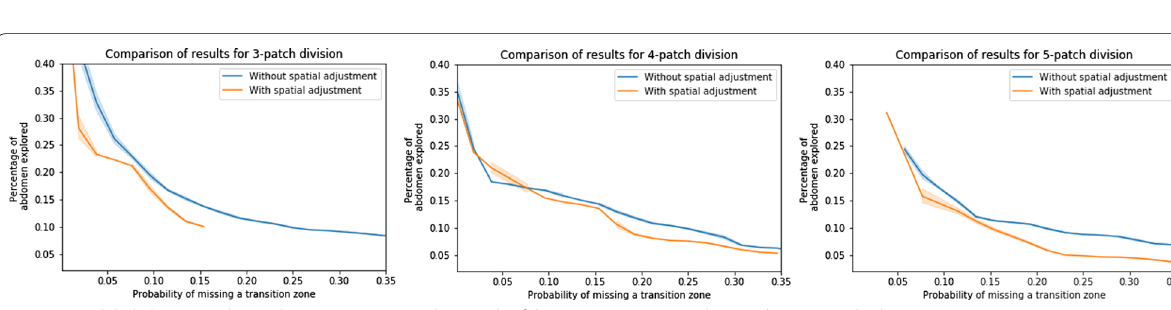
no change in the false-negative rate, but the searched abdominopelvic volume decreased by 4% (Fig. 6).